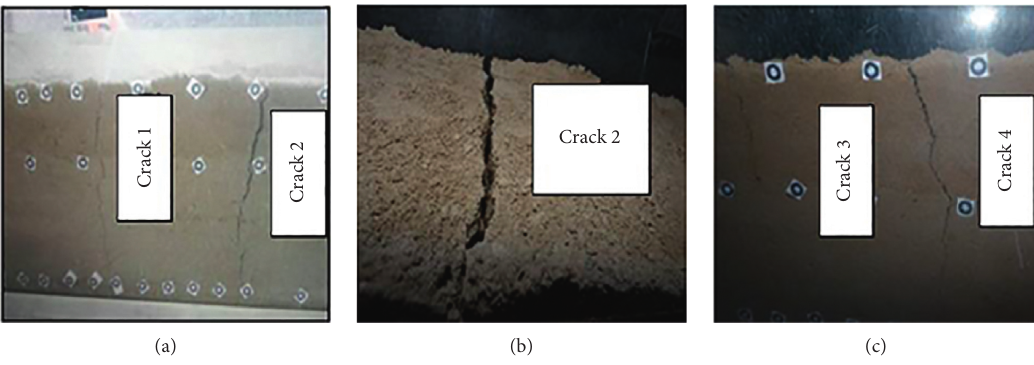
Figure 9: Local enlarged map of surface crack